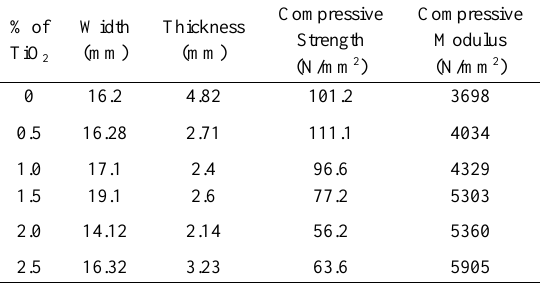
Fig.7 Compressive strength of epoxy-TiO 2 nanocomposites at different concentrations Table 3. Compressive properties of nanocomposites